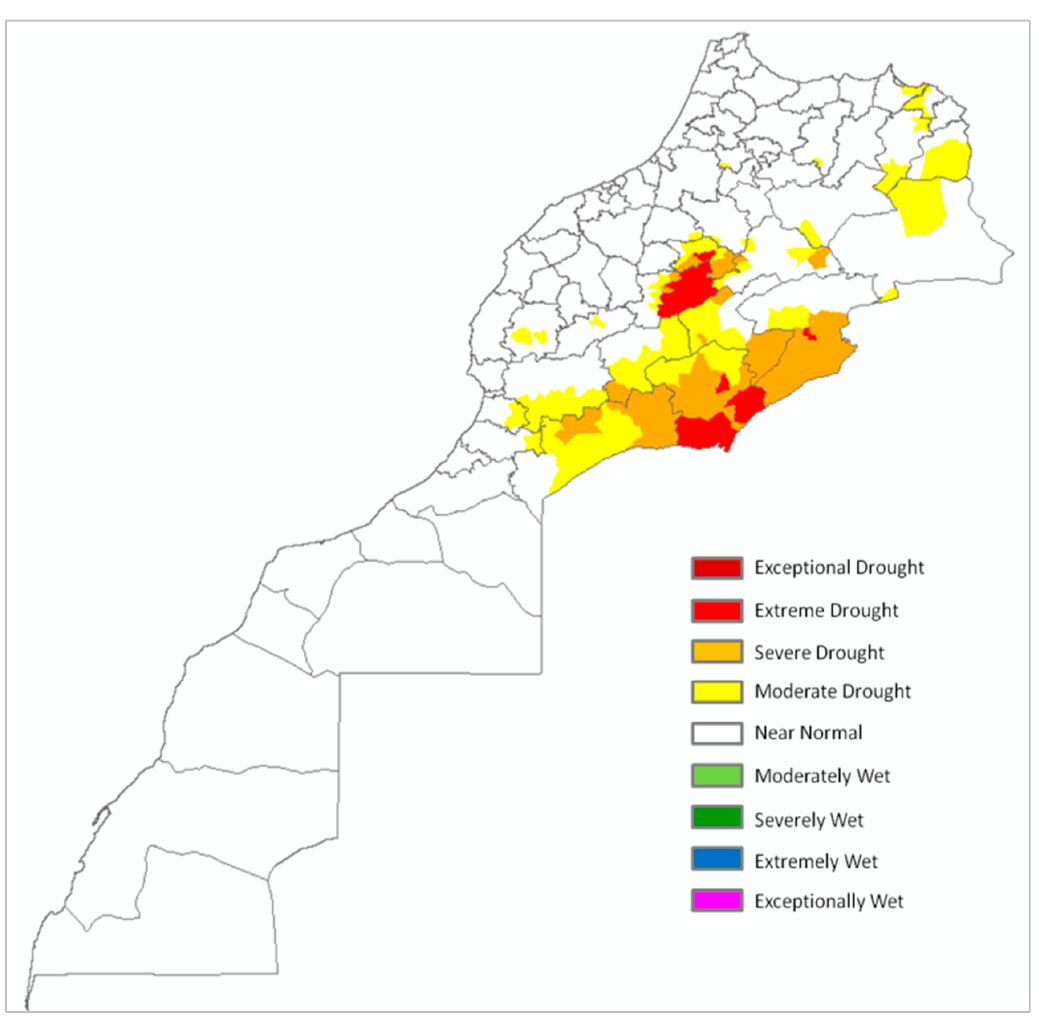
Figure 4. Example of 2-month Standardized Precipitation Index (SPI) (February 2016).